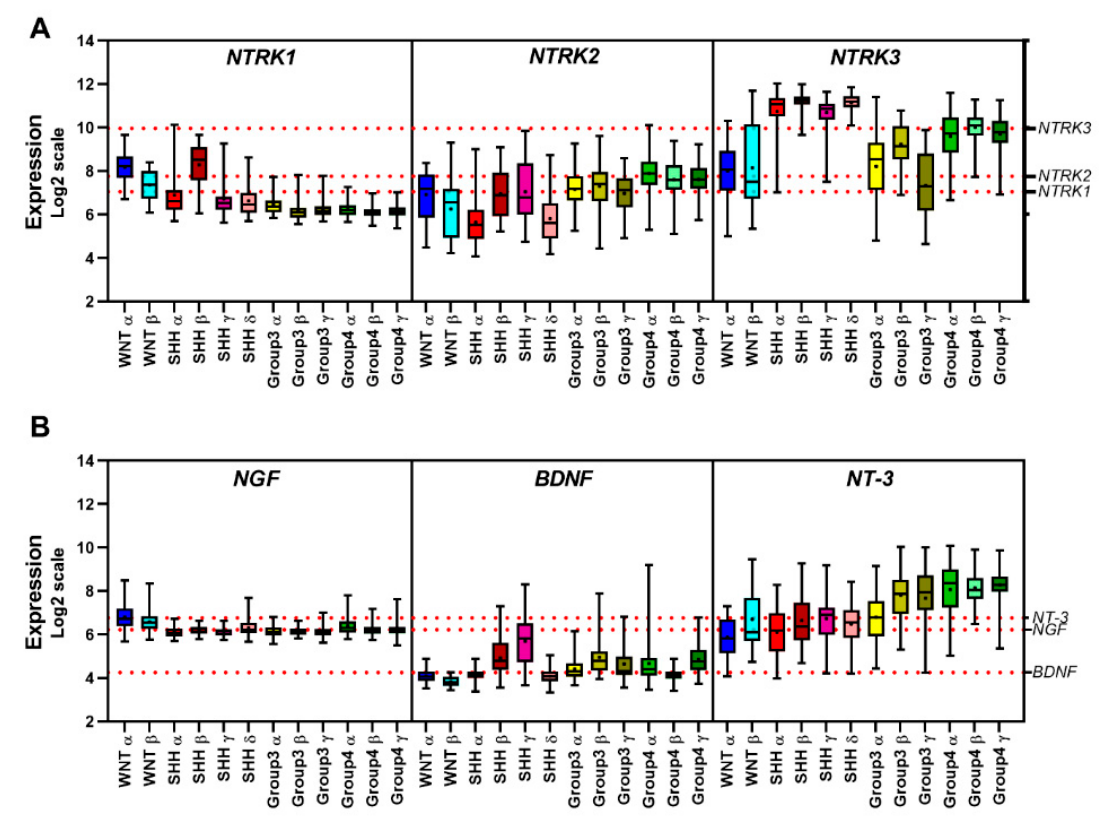
Figure 4. Transcript levels of neurotrophins and their receptors in tumors across the 12 MB molecular subtypes. Expression levels were examined in previously described transcriptome data set comprising tumor samples from patients in the Cavalli cohort ( n = 763 MB samples) [15]. Expression of NTRKs ( A ) and neurotrophins ( B ) across all samples is presented in boxplot format as log2-transformed signal intensity. Comparisons among subgroups were performed using a Kruskal–Wallis test followed by